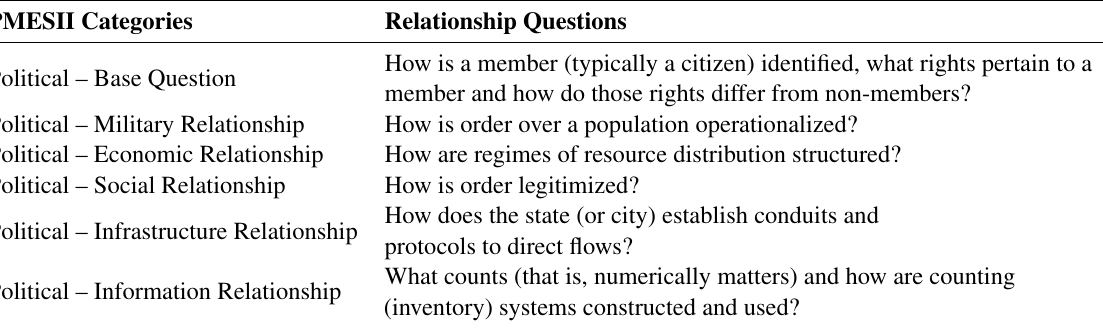
Questions for functional relationships between categories in the political relationships section.